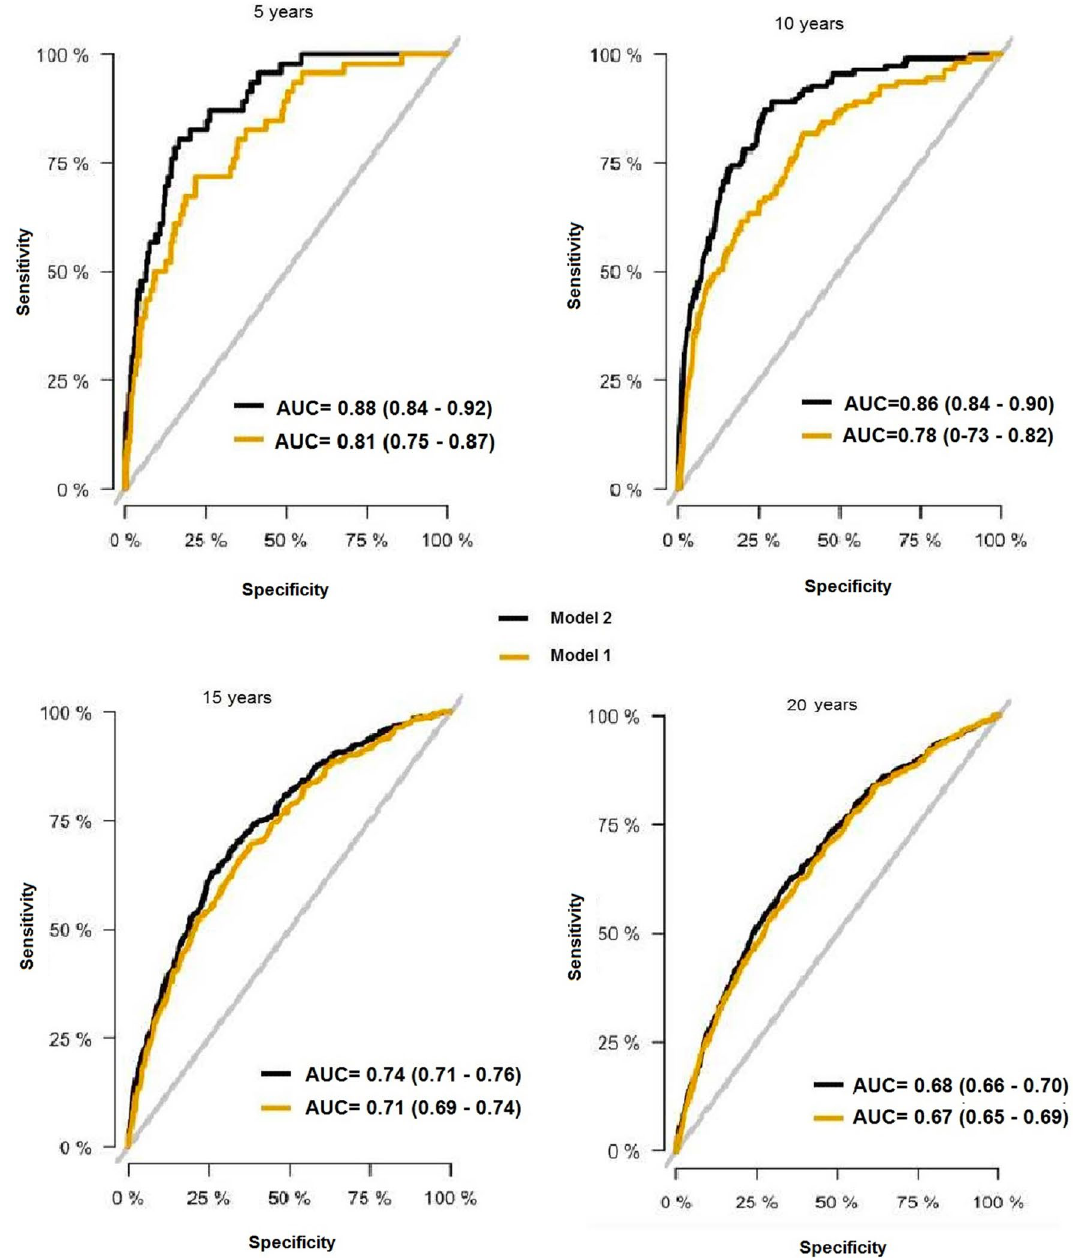
Figure 3. ROC curves for prediction of CVD mortality after 5-, 10-, 15- and 20-years follow-up. AUCs are given with 95% confidence intervals in brackets. Model 1: GRS 50 (continuous variable): adjusted for age, BMI, marriage status, family history of myocardial infarction, smoking, educational status, systolic blood pressure and prevalent diabetes. Model 2: GRS + paternal status (yes/no children): adjustments as in Model